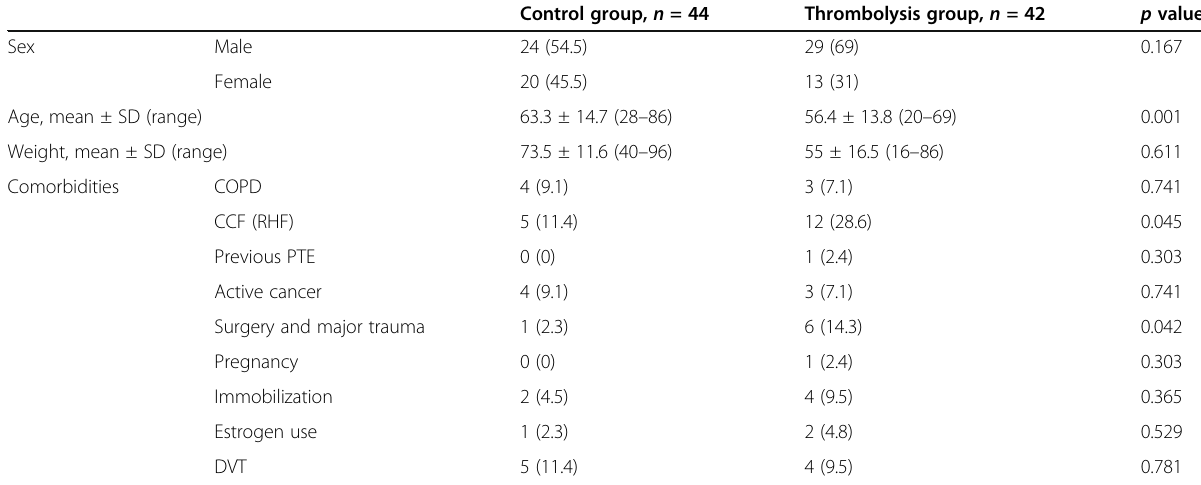
Table 1 Demographic features of the study population